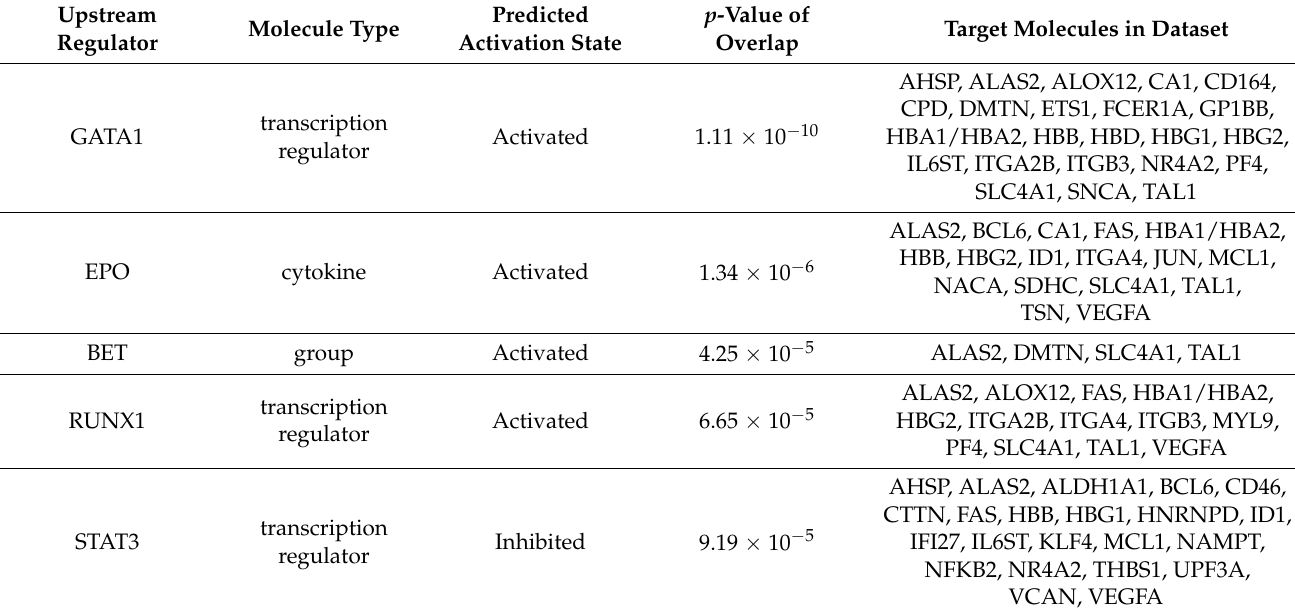
Table 3. Top five upstream